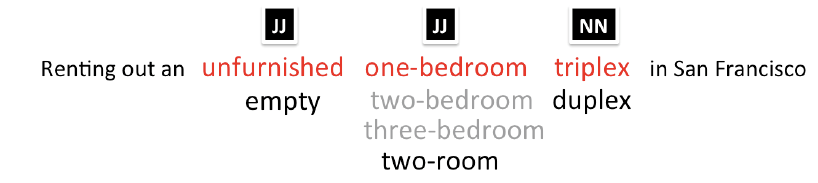
Figure 7: Illustrating the two-dimensional extension for POS